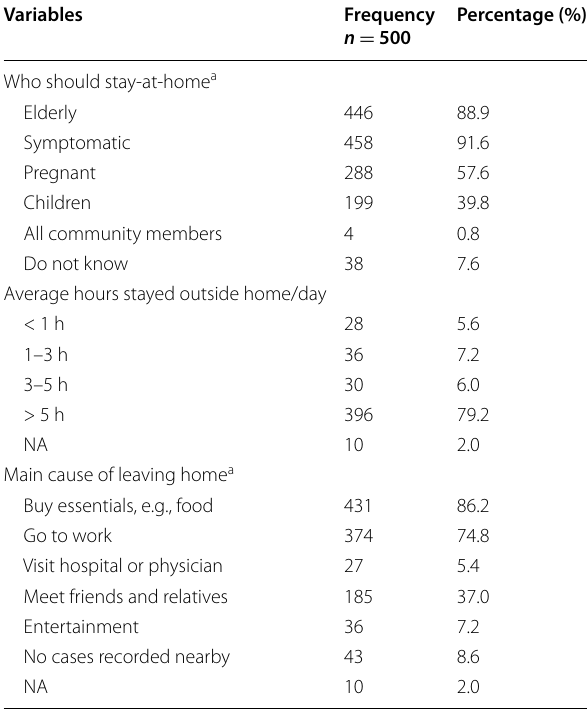
Table 3 Commitment to stay-at-home orders among studied population in Damietta Governorate, Egypt, during COVID-19